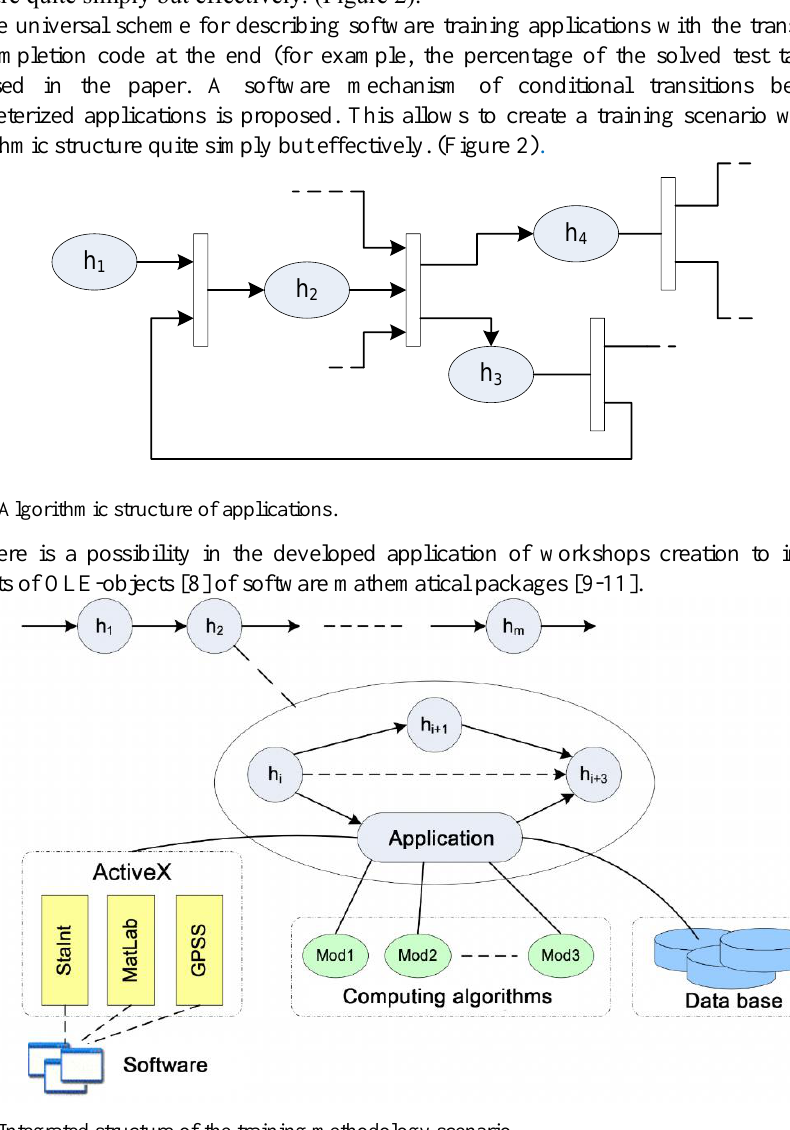
Fig. 3. Integrated structure of the training methodology